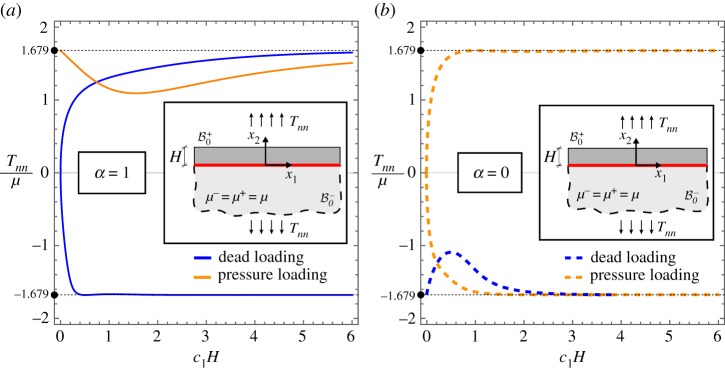
Bifurcation of a layer connected to an elastic incompressible half-space through a sliding interface. Both layer and half-space are modelled with the same neo-Hookean material and subject to the same prestress orthogonal to the interface. Both dead and pressure loadings are considered for the two interfacial conditions α=1 and α=0 (the latter condition is incorrect and included only for comparison). The normalized bifurcation stress Tnn/μ is reported versus the normalized wavenumber of the bifurcated field c1H. Note that for dead load bifurcation in tension is possible only when the correct interfacial condition, α=1, is considered. (Online version in colour.)